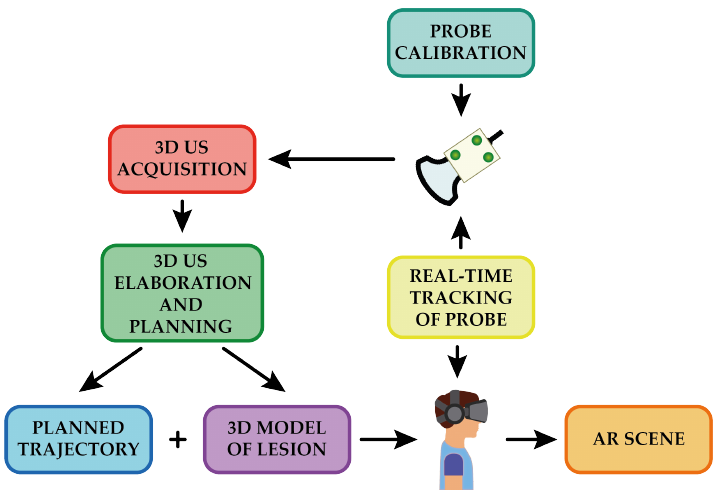
Figure 9. Overview of the workflow for the generation of the AR scene. Each participant was provided with a 21 G syringe (MTD Medical Technology and Devices S.A., Lugano, Switzerland) (0.8 mm external diameter) and was asked to wear the